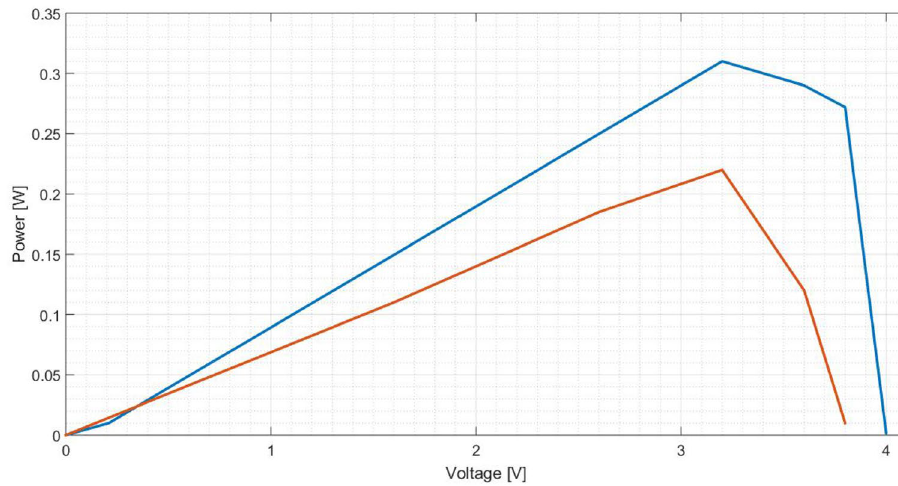
Figure 28. Comparison between P(V) curves of polished aluminium plate (Blue: Day 0; Red: Day 30).